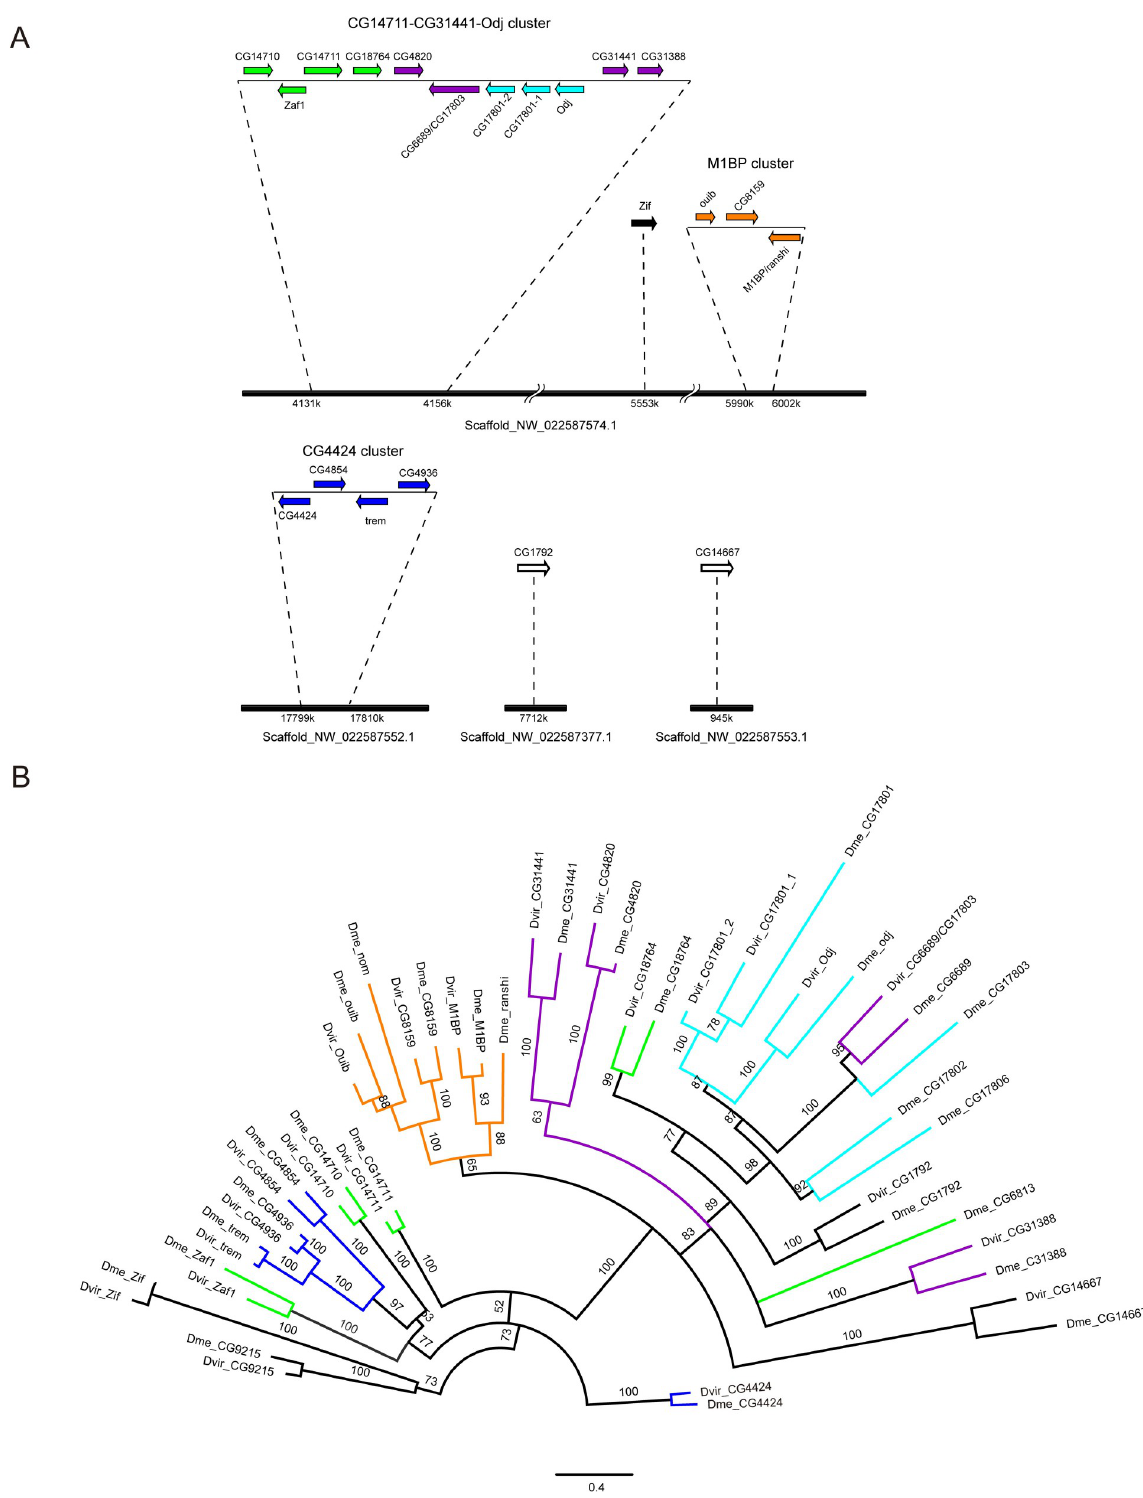
Fig 5. Cucoid clade protein tree is consistent with gene synteny in D . virilis . (A) Synteny of cucoid orthologs in D . virilis . Genes are color coded to indicate their relationship to gene clusters in D . melanogaster (see Fig 3 ). (B) Manually rooted maximum likelihood protein tree of Cucoid orthologs from D . melanogaster and D . virilis . Note that D . virilis has two CG17801 orthologs.